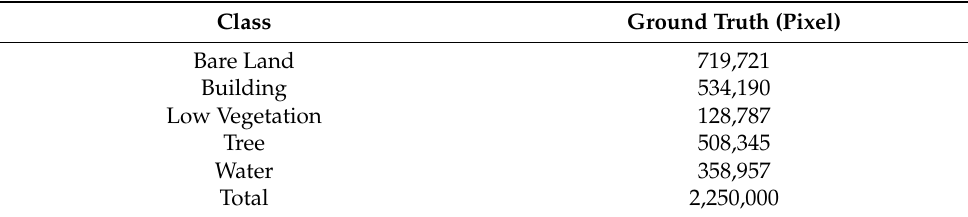
Table 4. Ground truths of the Vaihingen